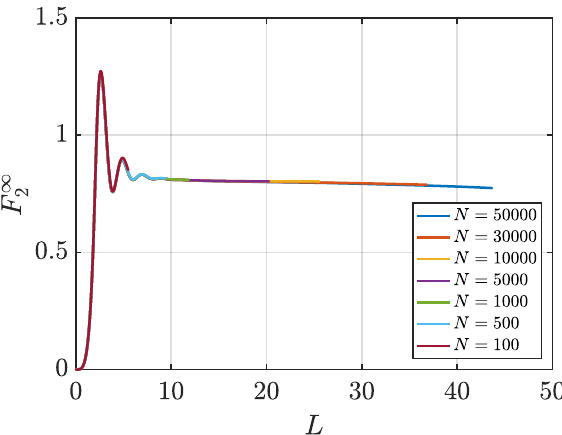
Figure 10. Estimation of the surface term in the thermodynamic limit F ∞ WCA fluid at T = 2 and ρ = 0.6 (dimensionless units). The values of F ∞ with varying number of molecules N . The used RDFs are provided in Figure 1.